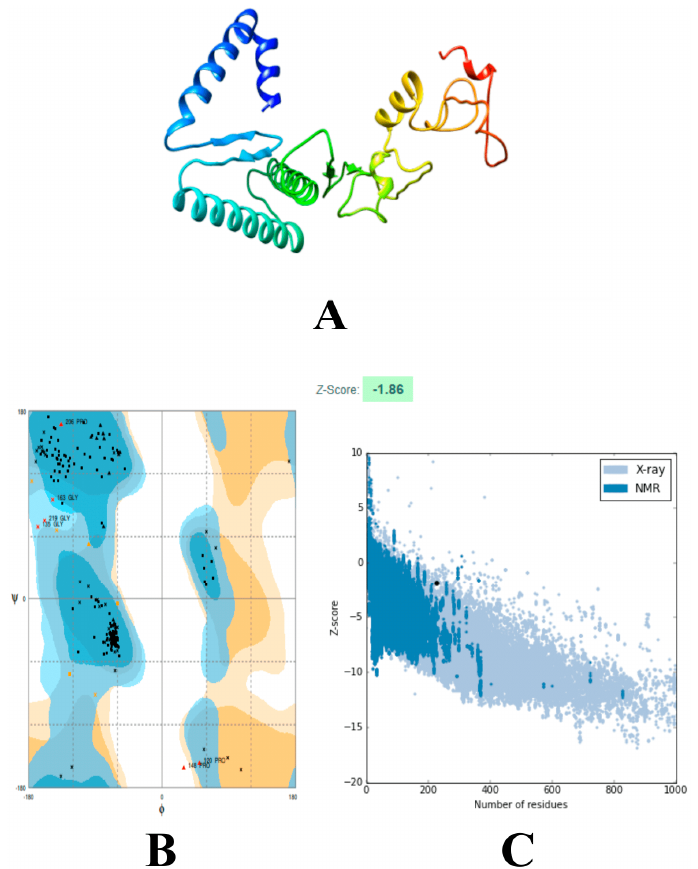
Figure 1. Structural analysis of designed vaccine. ( A ) The three-dimensional structure of vaccine obtained after molecular refinements; ( B ) Ramachandran plot analysis of the protein structure after molecular refinements. Analysis of the Ramachandran plot revealed that 94.7% of the residues of the vaccine are present in the favored region while 2.6% of the residues are present within the allowed and outlier regions, respectively; ( C ) ProSA-web evaluation of the vaccine structure. ProSA-web results indicated a Z-score of -1.86. The structure lies close to native X-ray resolved structures in the PDB (Protein Data Bank), which shows high-quality.